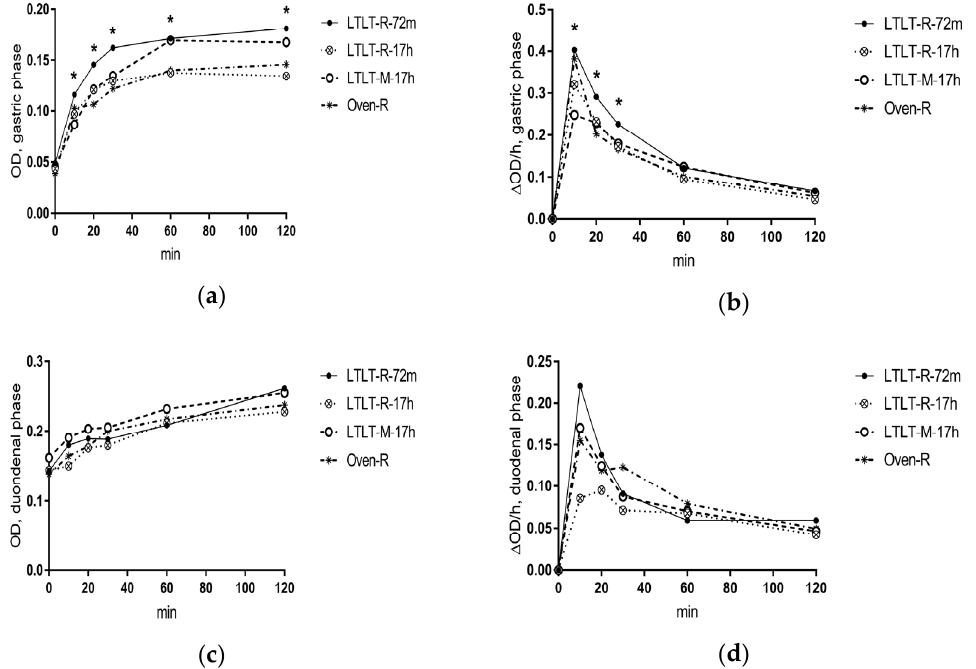
Figure 4. In vitro protein digestion in gastric phase: ( a ) optical density (OD) expressing the proteolytic activity and ( b ) the rate of proteolysis ( ∆ OD/h) and in the duodenal phase: ( c ) OD, and ( d ) ∆ OD/h. Significant differences at specific time points are indicated by *. The test meals were prepared according to Table 1.